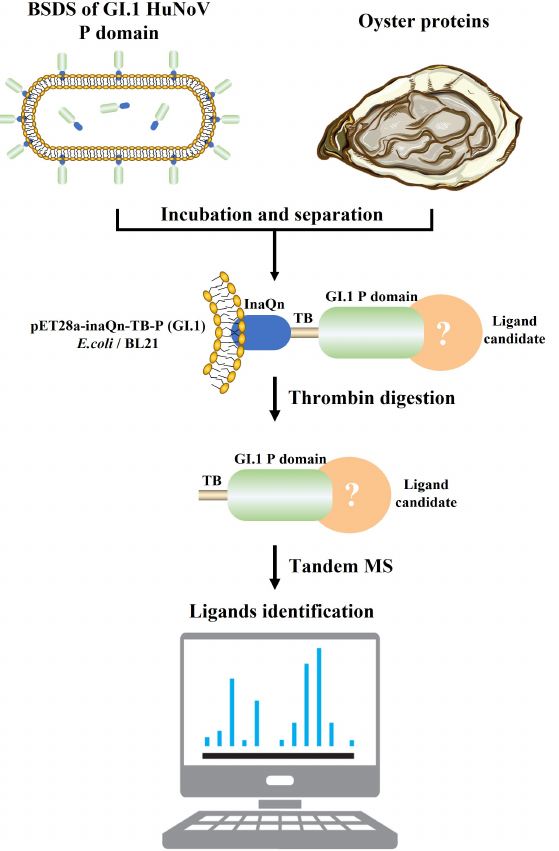
Figure 1. Brief workflow for the separation and identification of GI.1 HuNoV proteinaceous ligands in oyster tissues by BSDS. The BSDS was constructed and incubated with extracted oyster protein to pull down the potential proteinaceous ligand. The complexes of the P domain and ligand candidate were then released by thrombin. The complexes were then identified by a nanoliter liquid chromatography tandem with a quadrupole orbital trap mass spectrometer.